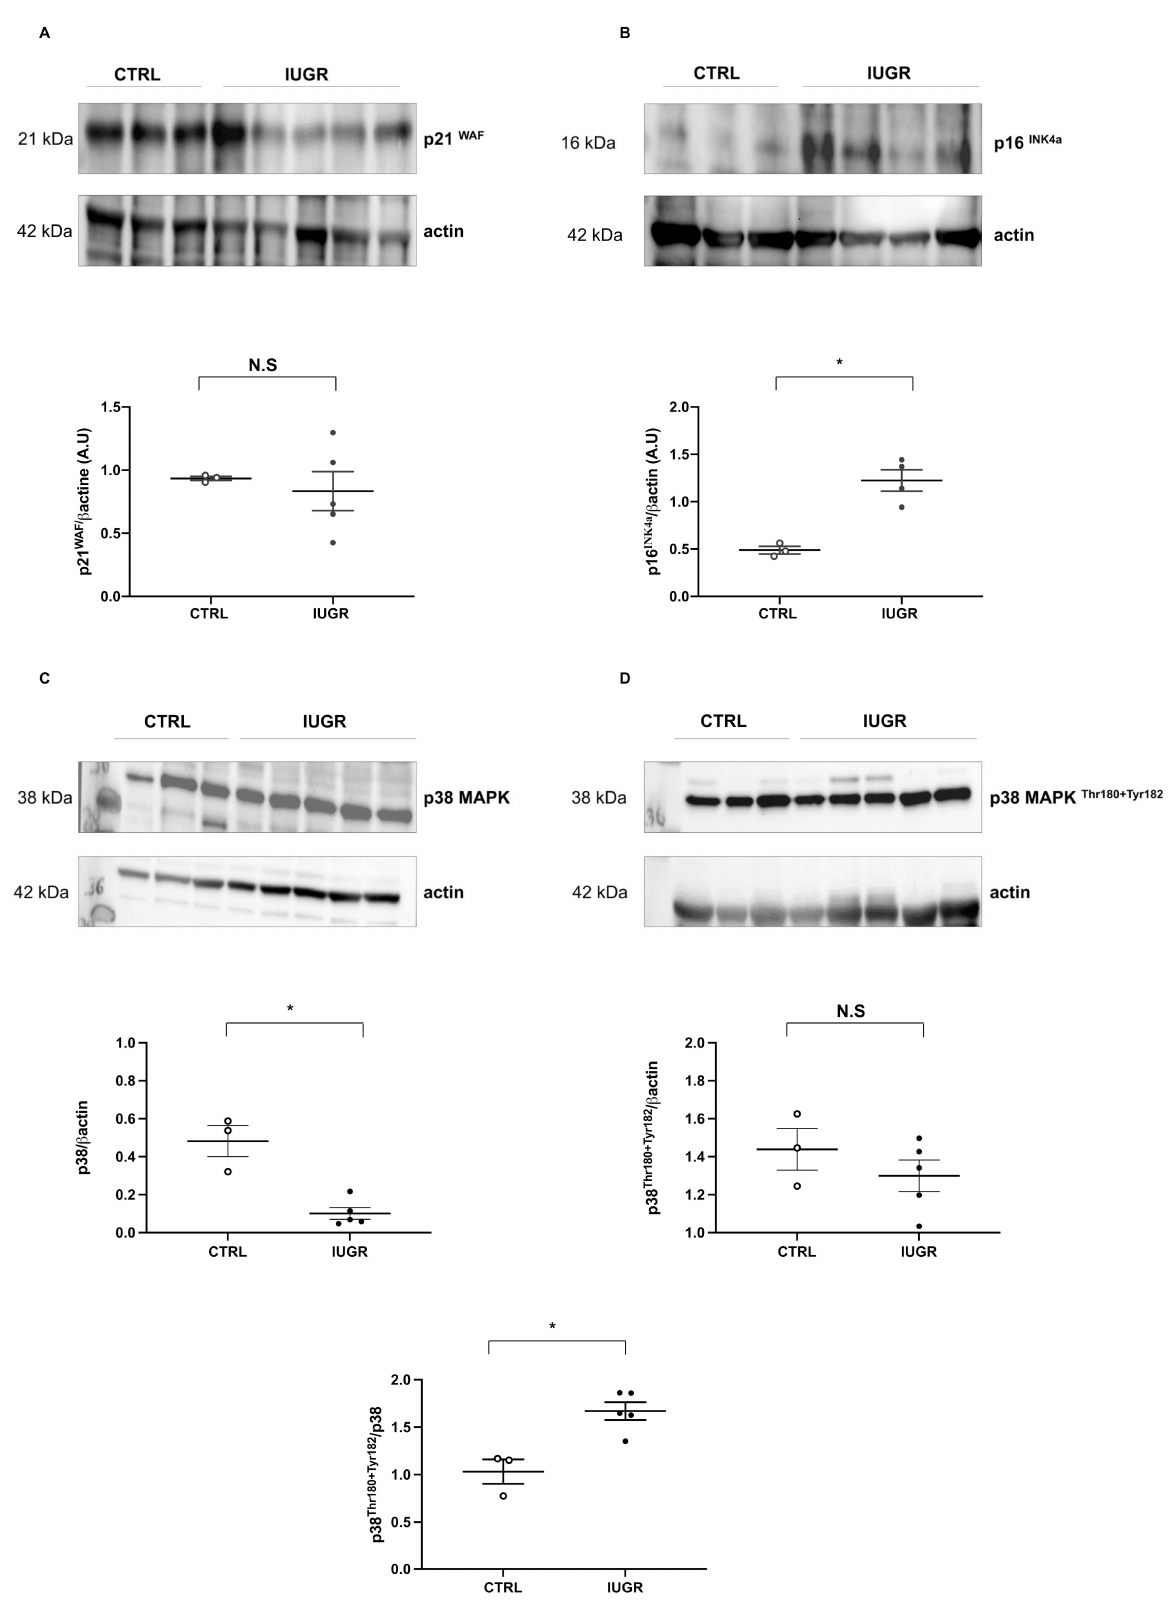
Figure 12. Factors related to cellular senescence. p21 WAF ( A ), p16 INK4a ( B ), p38 MAPK ( C ) and phosphorylated p38 MAPK Thr180+Tyr 182 ( D ) protein content were measured in CTRL-ECFCs and IUGR-ECFCs isolated from six-month-old male rats; n = 3–5 animals/group; * p < 0.05; N.S: not